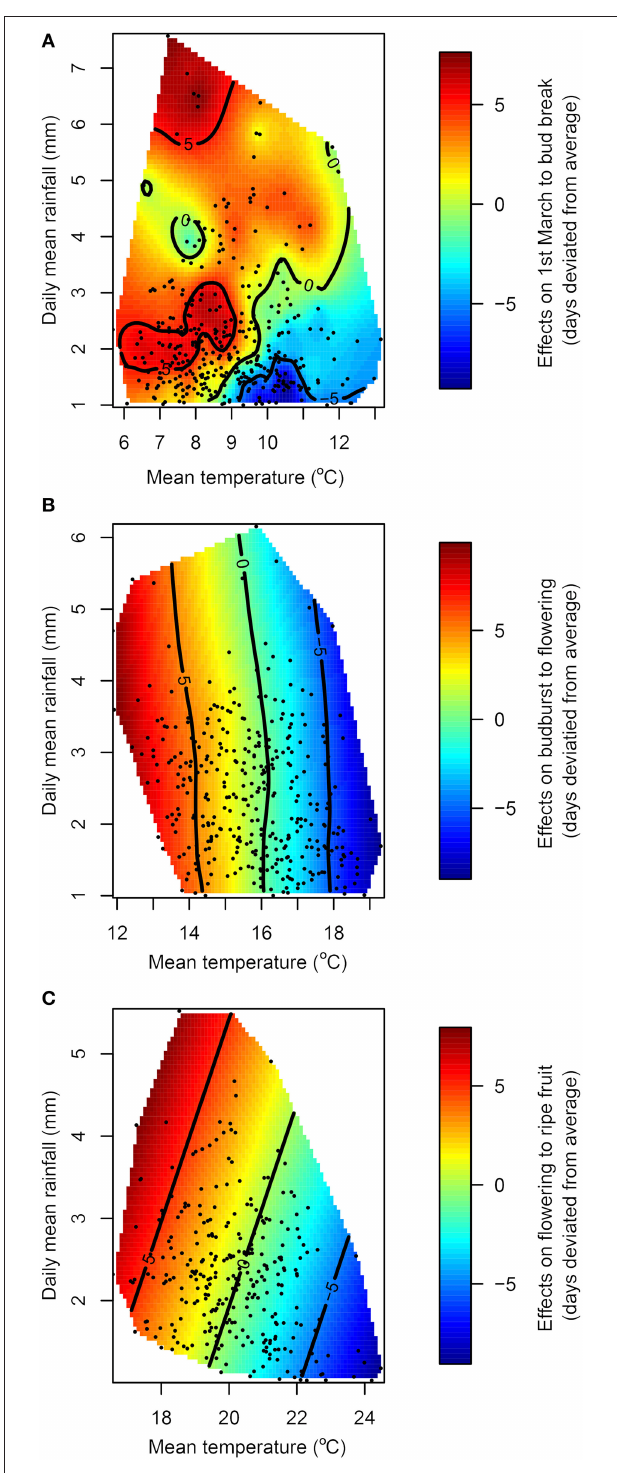
FIGURE 4 | Response of the length of the periods March 1st to budburst (A), budburst to flowering (B) and flowering to ripe fruit (C) to mean temperature and mean rainfall for each planting and year (historical data from 1961 to 2013). Colors and contour lines represent predicted deviation from the average length of each period expressed in days using observed data points of the length of each phenophase (black